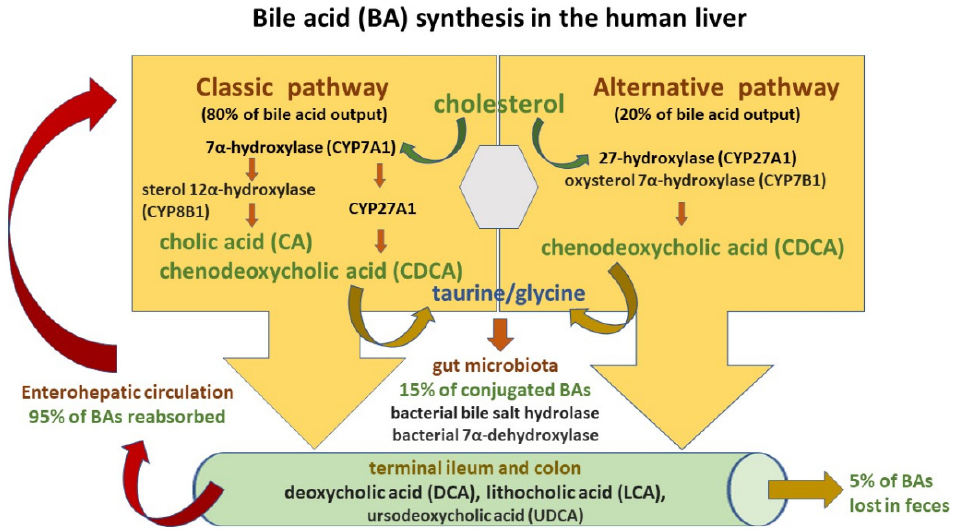
Figure 2. Bile acid (BA) synthesis and